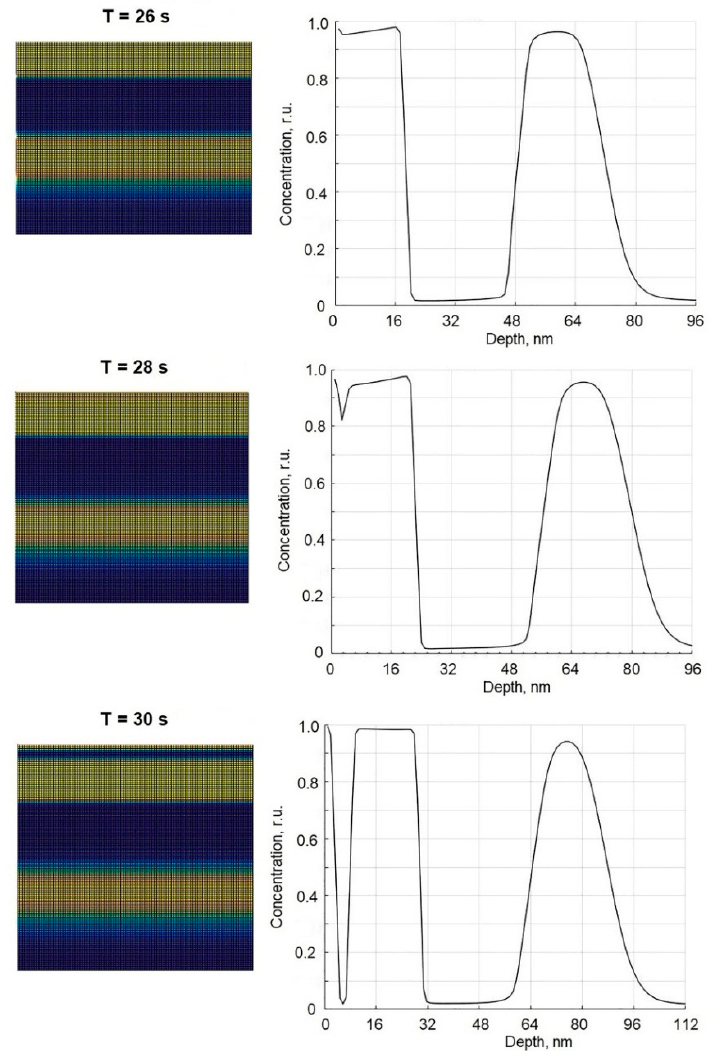
Figure 3. The kinetics of third layer formation: on the left the cross-section pictures of film structure at different moments of time and on the right the corresponding concentration profile of segregating component.